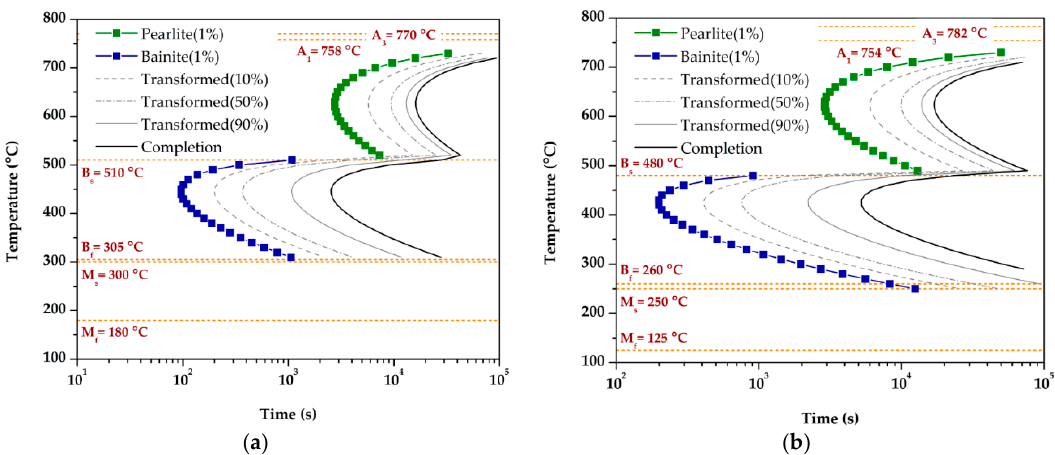
Figure 1. Influence of carbon content on transformation temperatures and the bainitic transformation nose on the TTT diagram: ( a ) 0.35%C; ( b ) 0.5%C.